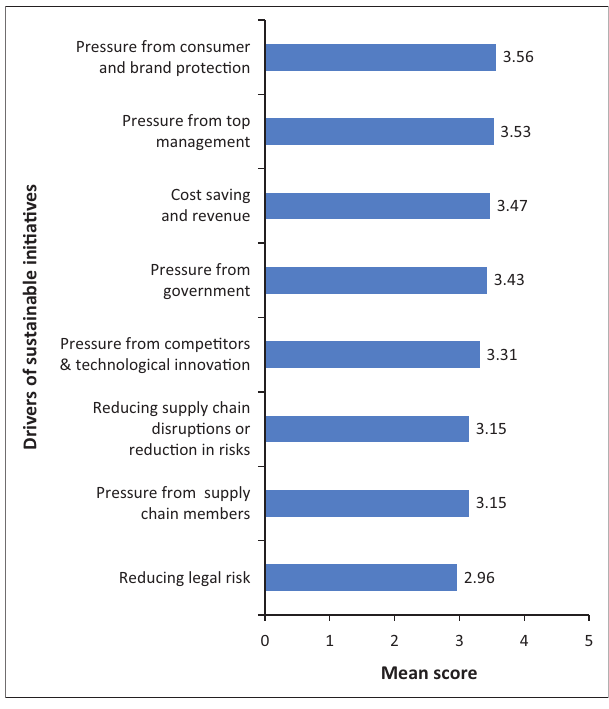
FIGURE 2: Drivers of sustainable initiatives in reducing greenhouse gas emission (mean